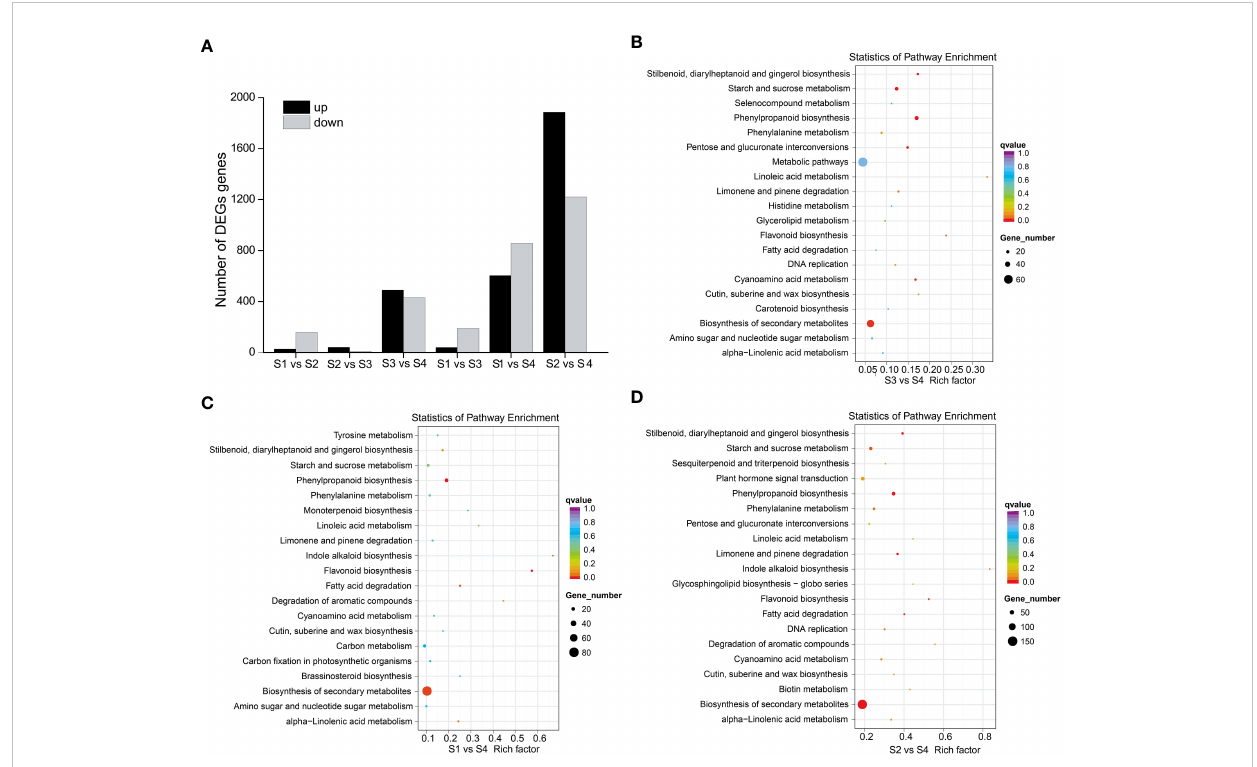
(evm.TU.scaffold 36.29, AtMYB12) was positively correlated with two ( HmCHS2 , HmANS1 ) structural genes.